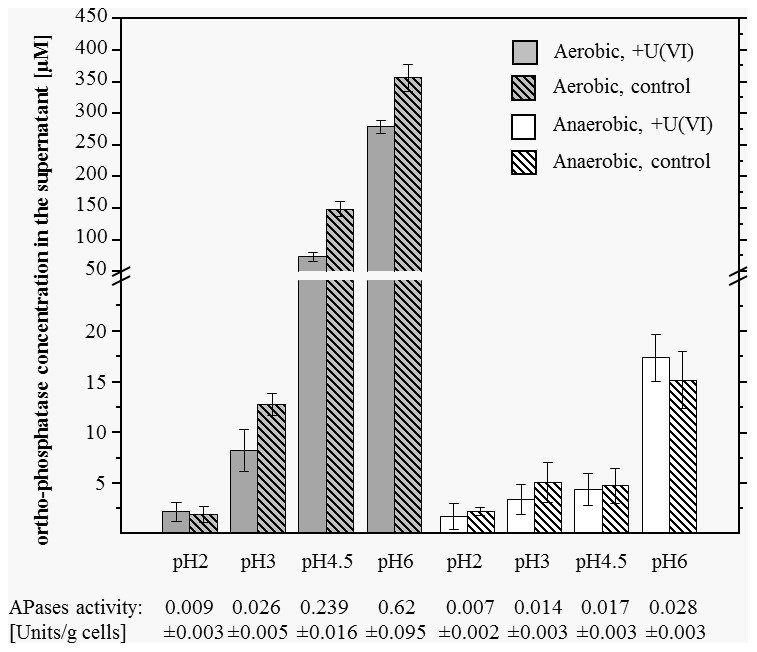
Amount of orthophosphate in the supernatant of cells of Paenibacillus sp. JG-TB8 after an incubation of 48 hours in dependency on pH, the aeration conditions and the presence of uranium.